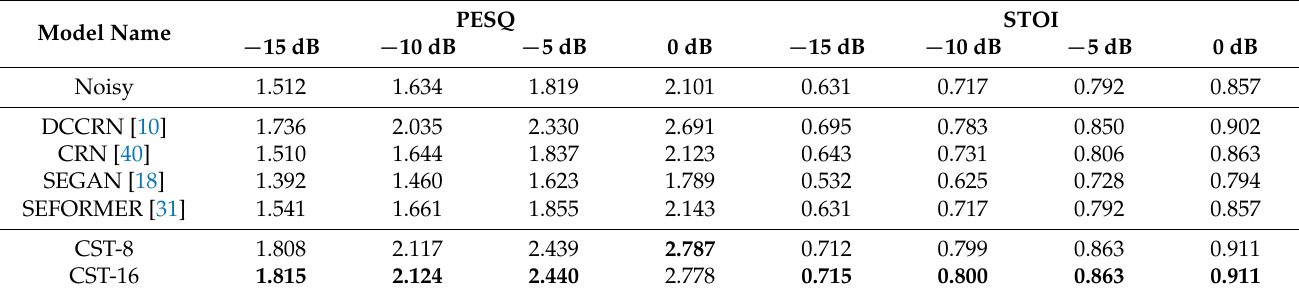
Table 1. Compare performance with other models in the MUSAN test